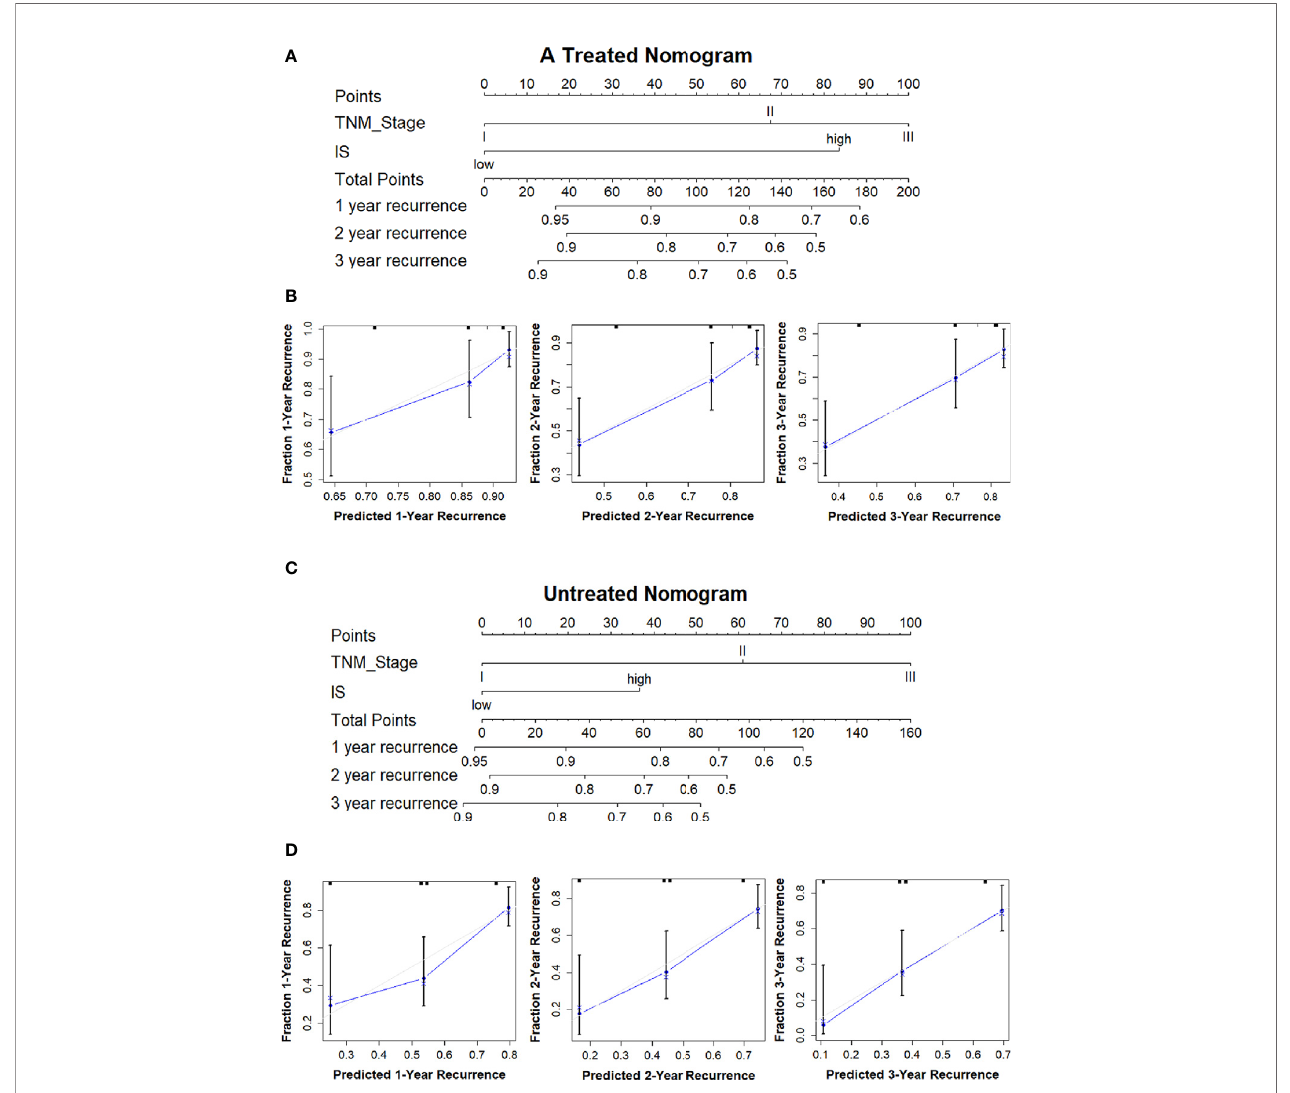
FIGURE 7 | Treated and untreated nomograms to predict the probability of 1, 2, and 3-year recurrence with or without adjuvant chemotherapy in GC. (A) Treated nomogram predicting 1-, 2-, and 3-year DFS for GC patients after surgery with adjuvant chemotherapy; (B) Calibration curves to validate treated nomogram for 1-, 2-, and 3-year DFS; (C) Untreated nomogram predicting 1-, 2-, and 3-year DFS for GC patients after surgery without adjuvant chemotherapy; (D) Calibration curves to validate untreated nomogram for 1-, 2-, and 3-year DFS. DFS , disease free survival; OS , overall survival; GC , gastric